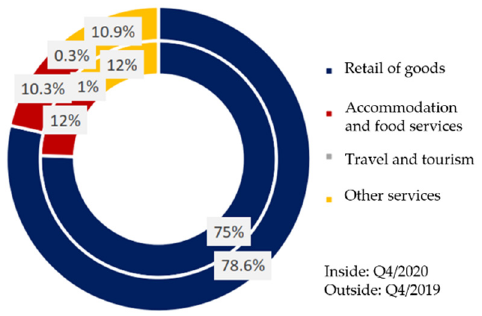
Figure 3. Revenue structure of the consumer industry.